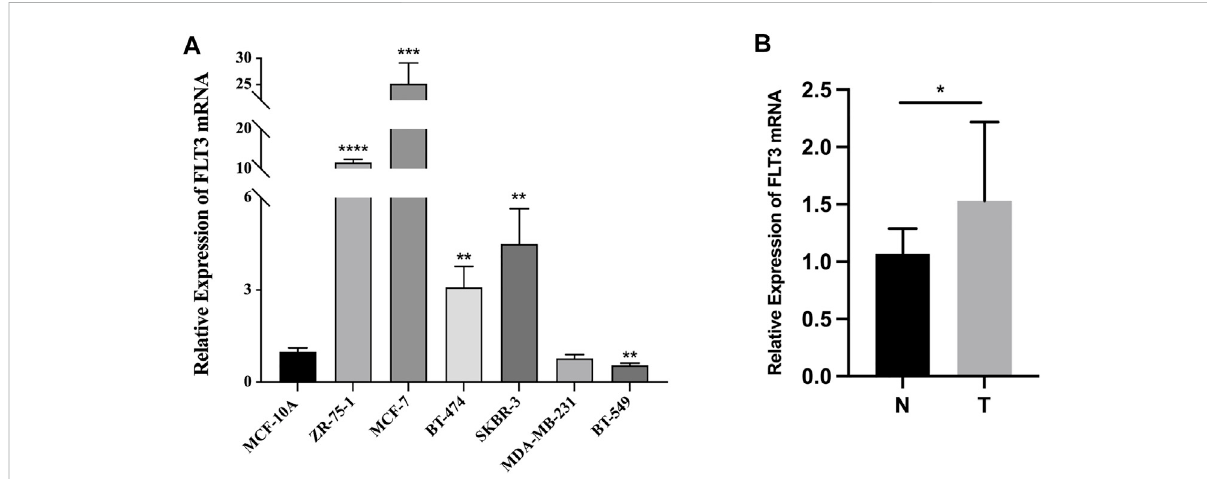
FIGURE 7 The mRNA expression of FLT3 in BC cell lines and tissue samples. (A) Relative expression level of FLT3 in MCF-10A, ZR-75-1, MCF-7, BT-474, SKBR-3, MDA-MB-231, and BT-549 cell lines. (B) The qRT-PCR result which compared the expression levels of FLT3 in tumor and para-carcinoma tissue of BC patients. The asterisks represent the statistical p -value (ns: p > 0.05, * p ≤ 0.05, ** p ≤ 0.01, *** p ≤ 0.001, **** p ≤